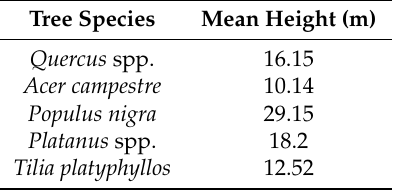
Table 4. Estimated (SfM approach) mean H values of the dominant species in all the sample plots.